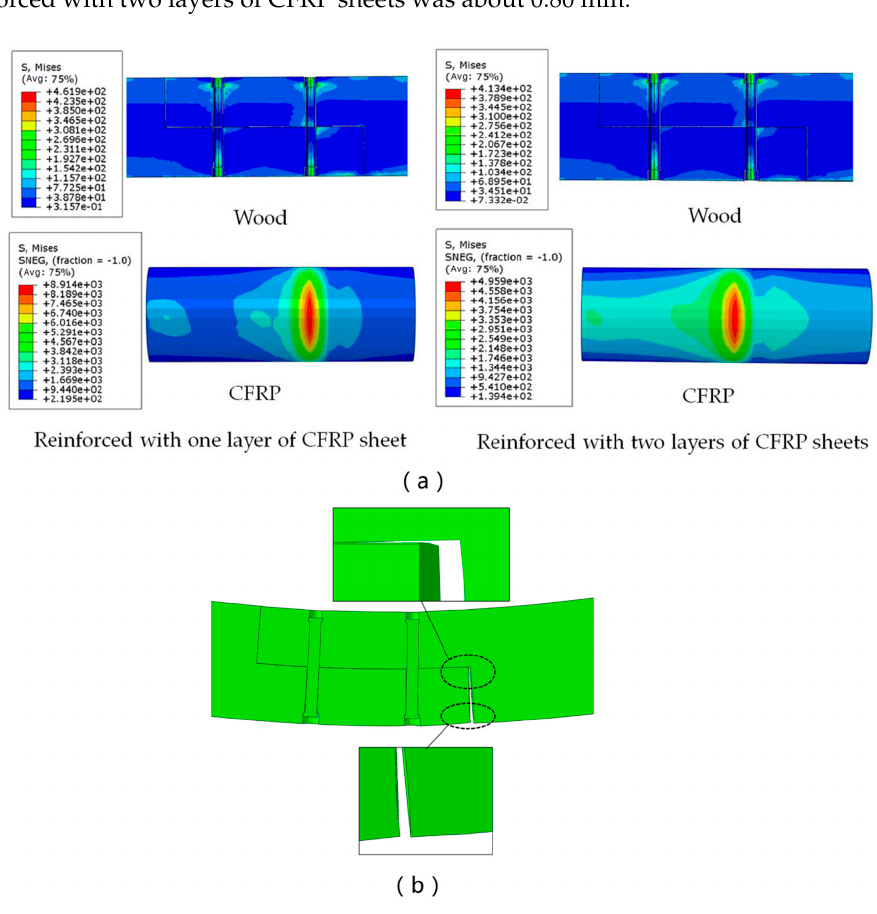
Figure 12. Comparison of experimental and numerical results. ( a ) Reinforced with two layers of CFRP sheets; ( b ) reinforced with one layer of CFRP sheet.